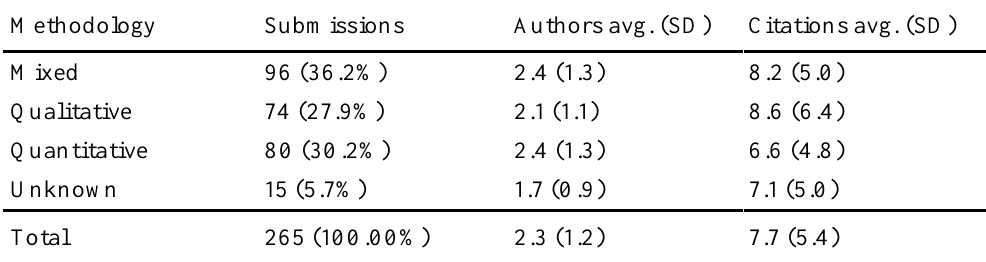
Phase 1 Distribution of Research